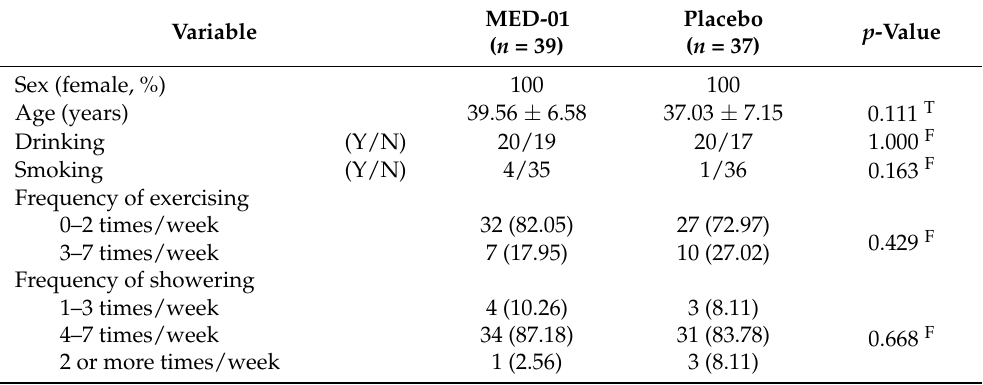
Table 2. Demographic and lifestyle characteristics of the participants at the